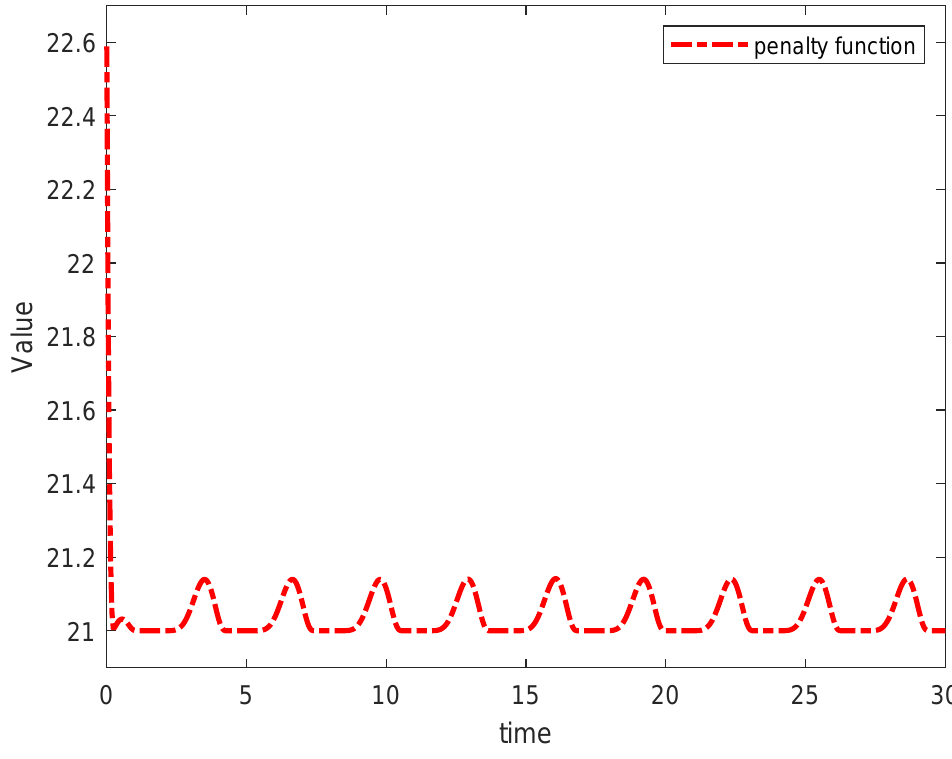
Figure 20. The value of penalty function based on the finite-time distributed